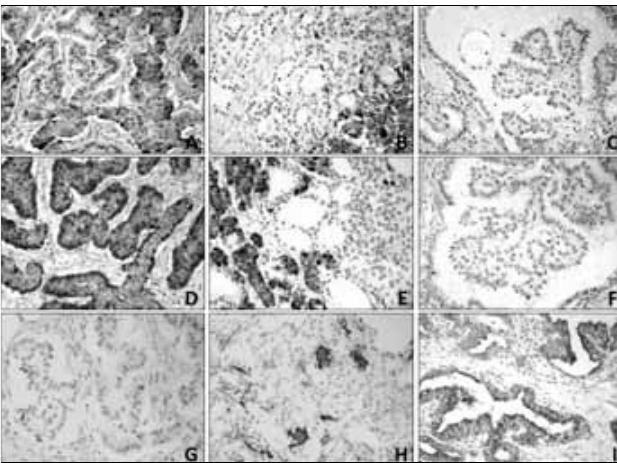
figurE 2 – Immunoexpression of histological components from strumal carcinoid tumor and papillary thyroid carcinoma Chromogranin A (A, B and C), PSAP (D, E and F) and thyroglobulin (G, H and I) immunoexpression in the trabecular carcinoid component from the transition area between the thyroid and carcinoid tissue and in papillary thyroid carcinoma. The reactions for chromogranin A and PSAP highlight the existence of hybrid cells in the transition areas between carcinoid and thyroid tissue (B and E) (400×). PSAP: Prostatic acid